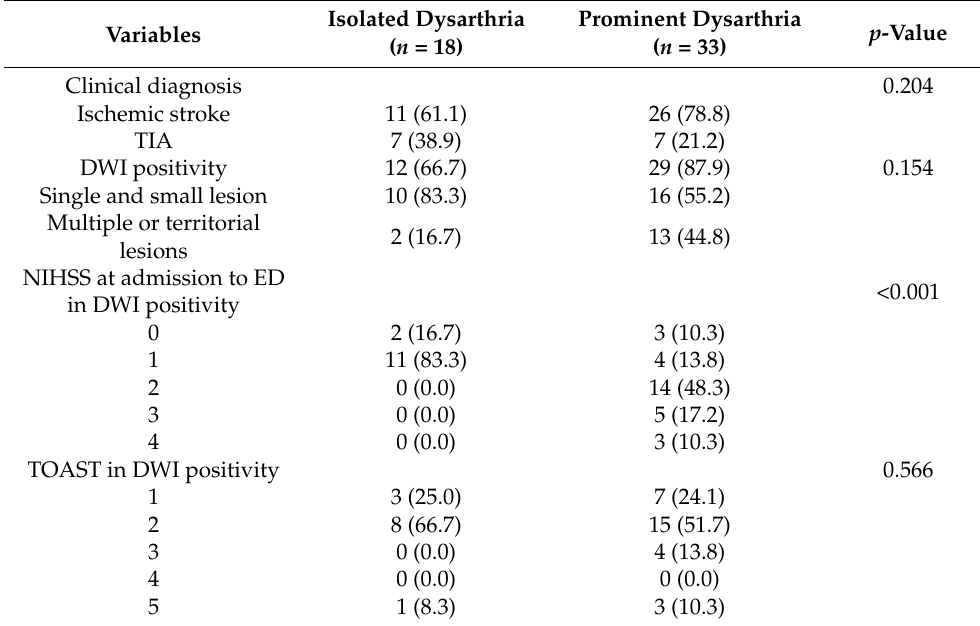
Table 4. Comparison between isolated and prominent dysarthria in patients with acute ischemic stroke or